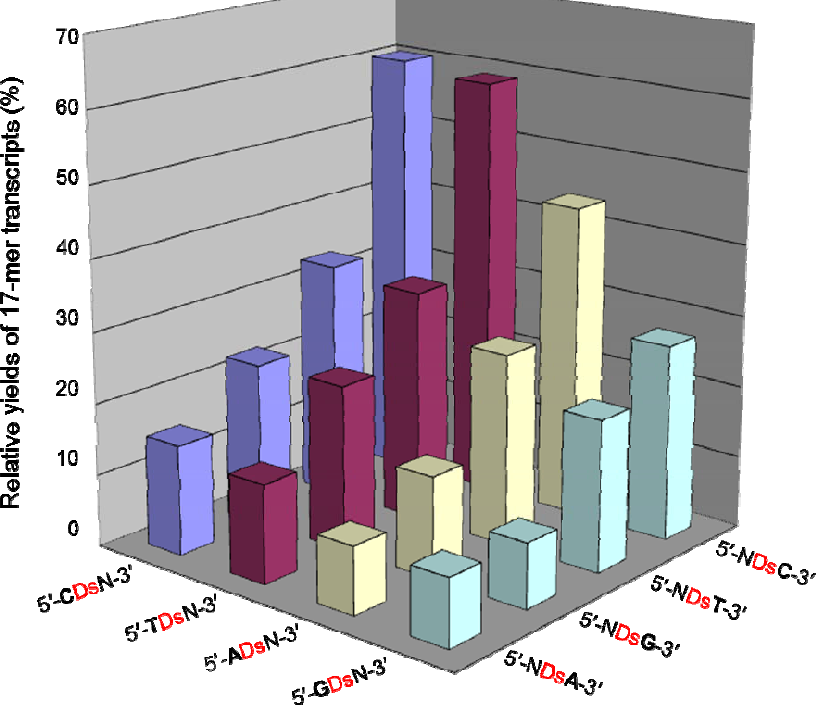
Figure 7. Plot of the relative yields of the 17-mer transcripts from the template containing a 3 ′ -N Ds N -5 ′ sequence (N , N = A, G, C, or T), in the presence of Pa TP. The relative 1 2 1 2 yield of each full-length transcript was determined by comparison to the yield of the native transcript from the template consisting of the natural bases only. The values were averaged from three data